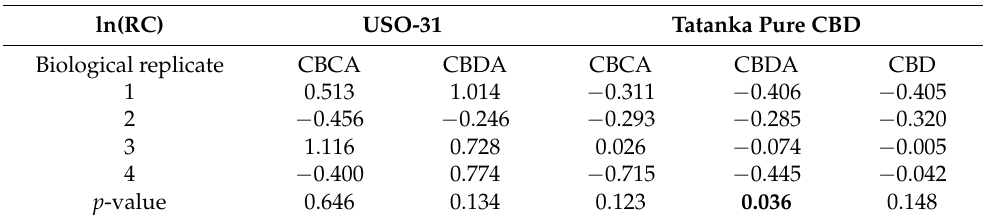
Table 3. Results from the t -test applied on RC in both cultivars. The p -value that denotes the statistical significance is in